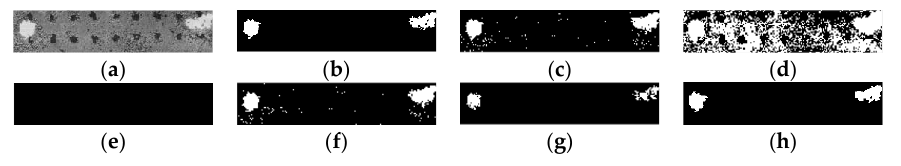
Figure 8. Image6 and its segmentation results: ( a ) #image6, ( b ) ground-truth, ( c ) Otus, ( d ) MRCUT,